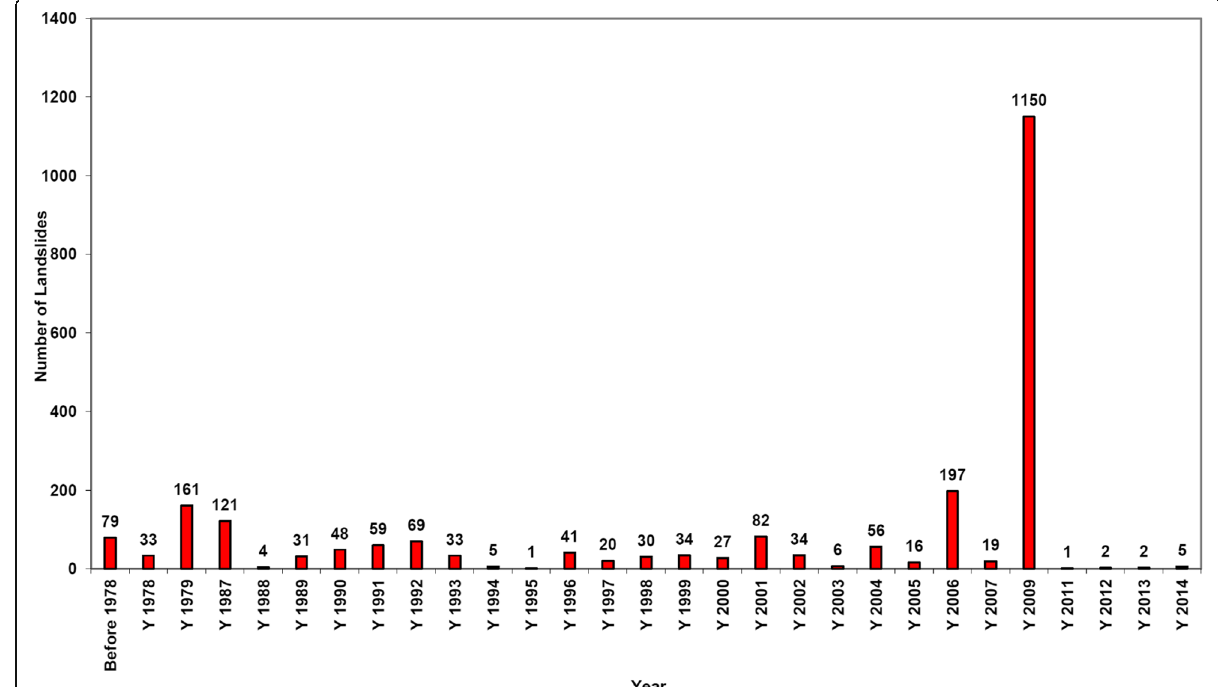
Fig. 4 Year wise landslide occurrence in Nilgiris